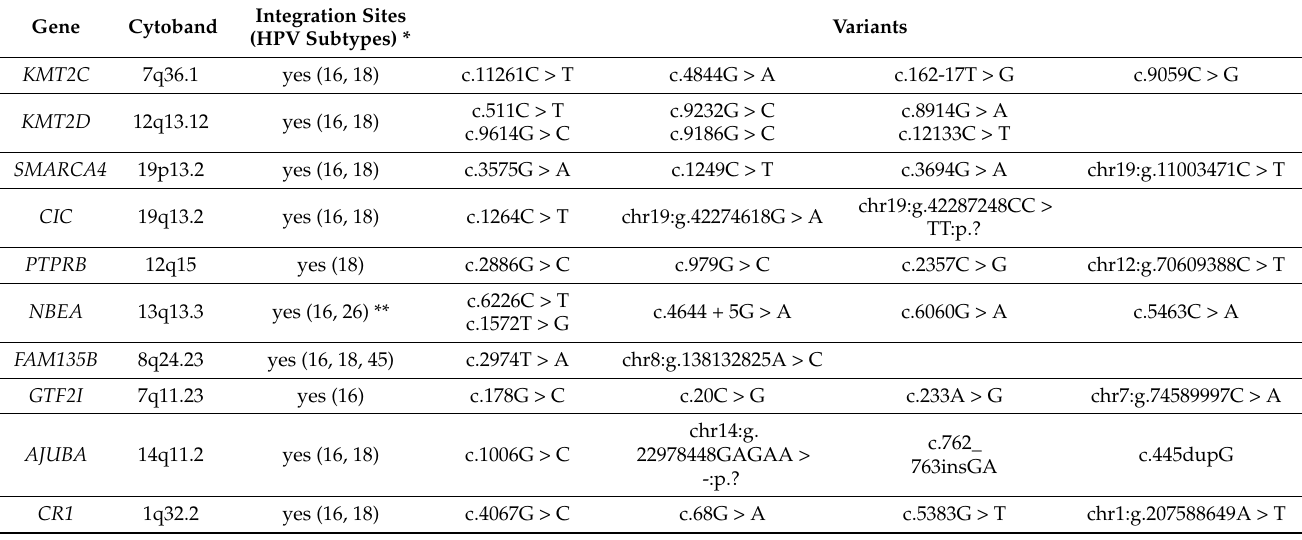
Figure 3. Common genes described in four studies in which whole-exome sequencing was performed in penile carcinomas, including the present study. Data from Europeans, Asians, and North Americans were adapted from [14–16], respectively. Left side of the figure: genes observed exclusively in penile squamous cell carcinomas of Latin American patients. Table 2. Cancer-associated genes presenting variants detected by whole-exome sequencing in hu- man-papillomavirus—associated penile squamous cell carcinomas exclusively altered in Latin American patients.